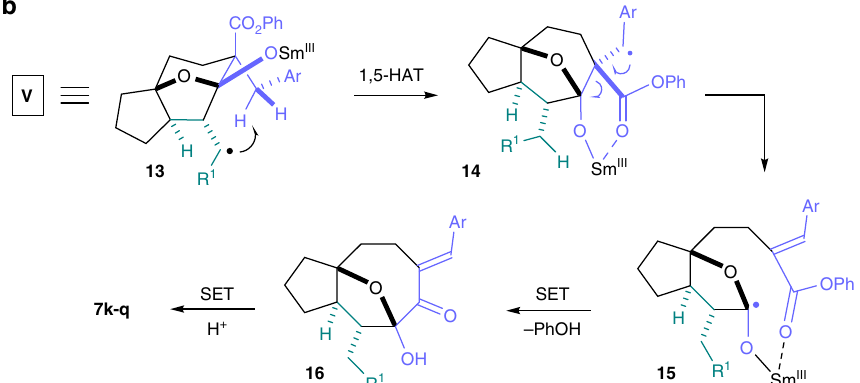
Fig. 5 Folding radical cascades involving 1,5-HAT and activation of a benzylic group. A samarium(II) folding cascade involving activation of benzylic groups by 1,5-HAT in key radical intermediates V is shown. a The scope of the samarium(II) folding cascades involving benzylic group activation by 1,5-HAT to give products 7k – q . b The mechanism of folding involves 1,5-HAT in key radical intermediates V to give 14 and subsequent fragmentation to give ketyl-type radicals 15 . Intramolecular acyloin reaction then delivers 16 that undergo diastereoselective reduction to give products 7k –